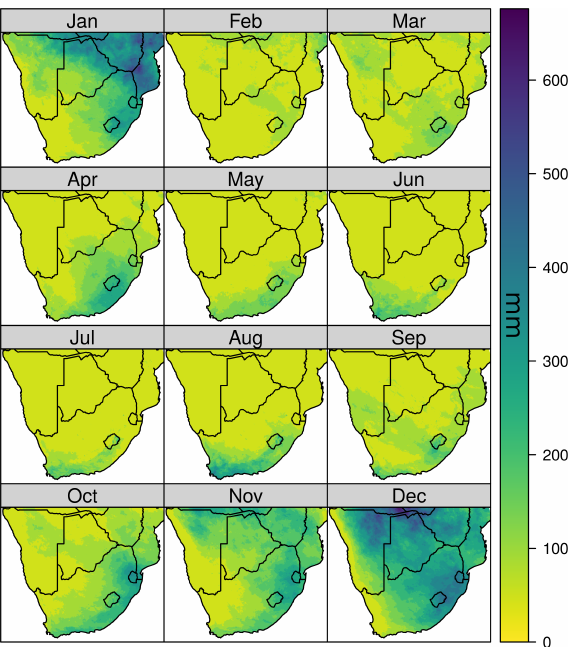
Figure 7. Monthly precipitation sums in millimetres from the year 2013 as estimated by this study.